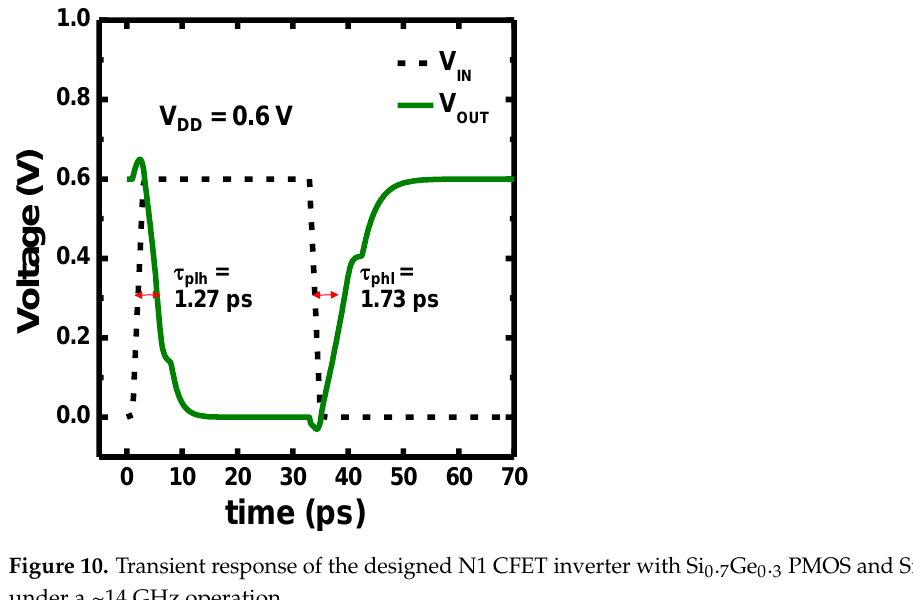
Figure 9. ( a ) The voltage transfer curves (VTC) of CFET inverter with Si 1-x Ge x PMOS and Si NFET. ( b ) The inverters’ switching thresholds (V M ) versus x in Si 1-x Ge x PMOS with V DD = 0.5, 0.6, and 0.7 V, and the dotted lines represent where the V M equals V DD /2.